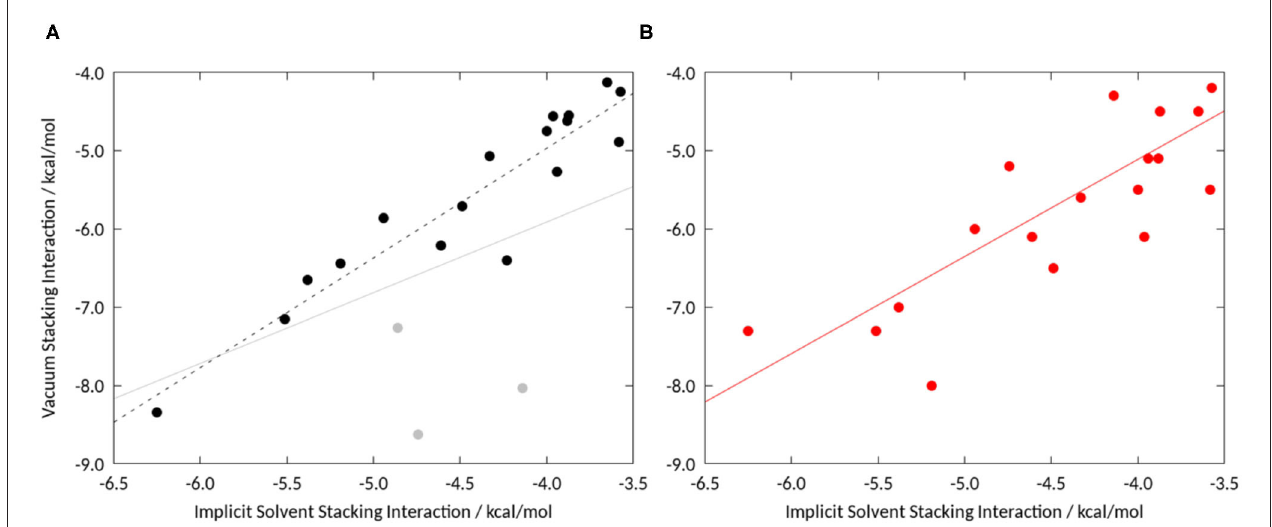
FIGURE 3 | (A) Correlation of vacuum stacking interactions from an unrestrained geometry optimization with stacking interaction energies in implicit solvent: The Pearson correlation including the three compounds favoring T-stacked geometries (indicated in gray) is 0.74, without these three the correlation increases to 0.94. (B) Comparison of a grid-based approach by Bootsma et al. (2019) to identify minimum energy geometries with unrestrained geometry optimization in implicit solvent. We obtain a Pearson correlation of 0.77.